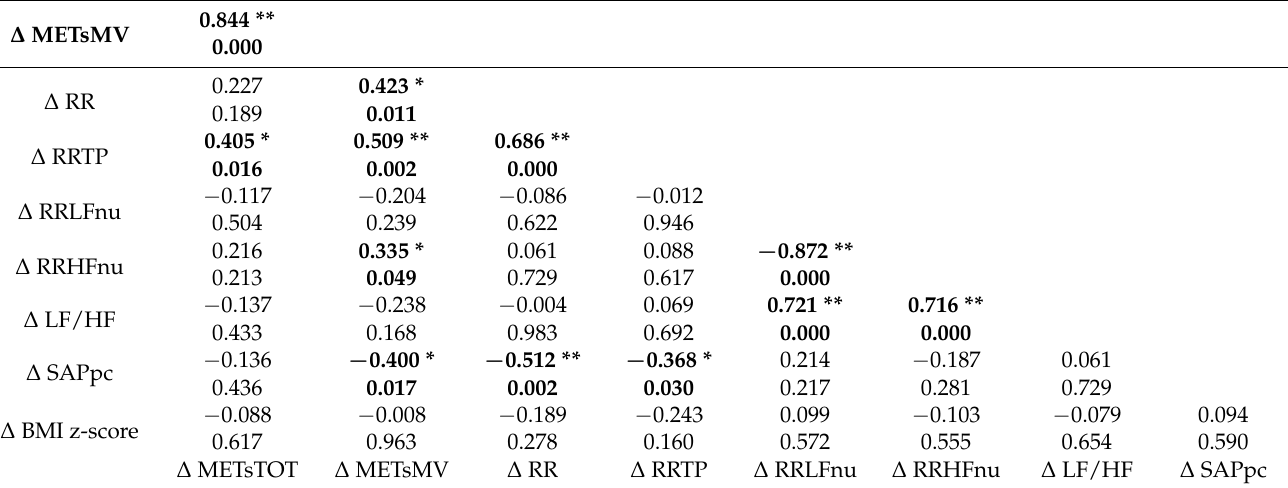
Table 3. Pearson’s correlations among changes between T0 and T1 of main